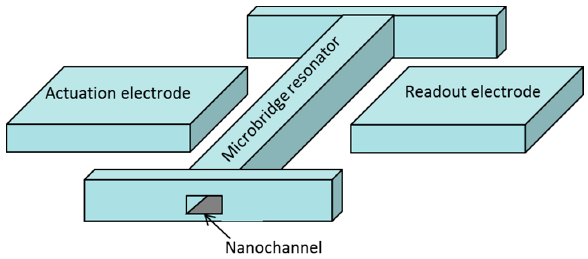
Figure 1. Conceptual sketch of a suspended nanochannel resonator (SNR) formed by an in-plane microbridge resonator and a nanochannel embedded inside.